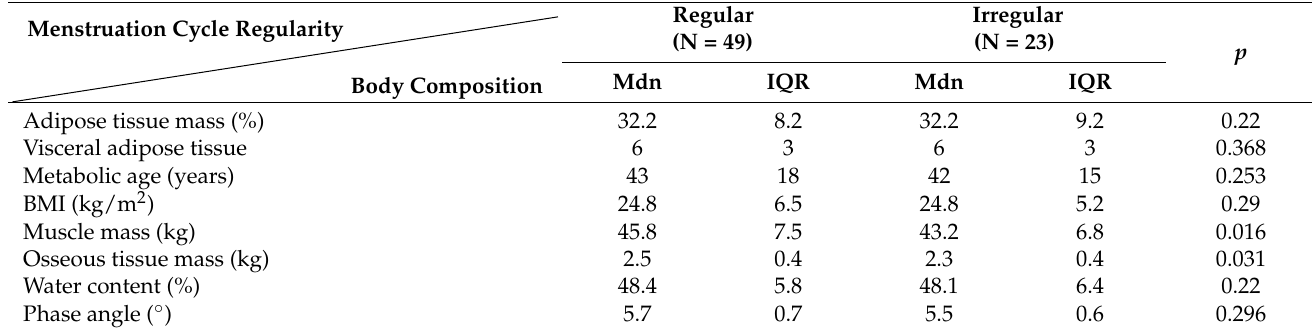
Table 8. Body composition analysis considering the regularity of the menstruation cycle.